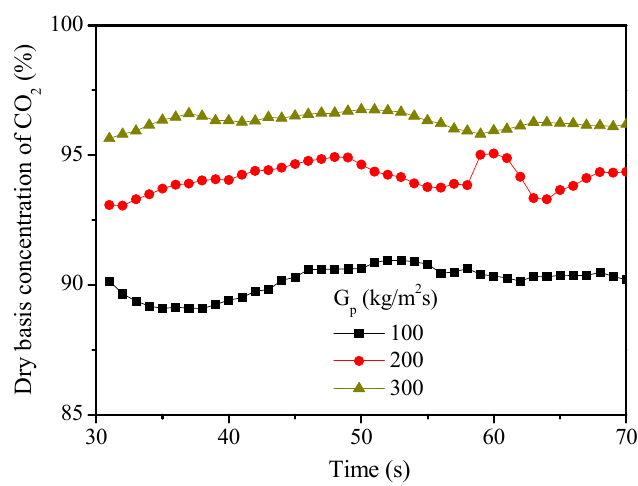
Figure 6. Effect of solids flux on the CO 2 concentration (dry basis) at the outlet of the fuel reactor.